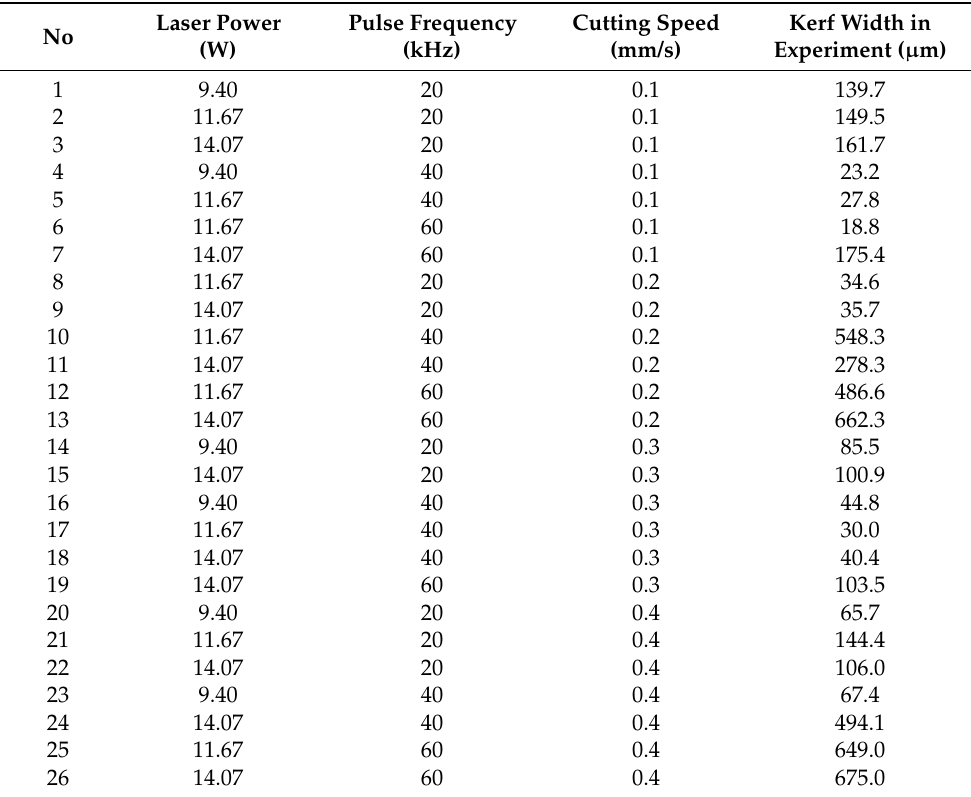
Figure 3. Structure of CNN model for kerf width prediction. Table 2. Experimental dataset.